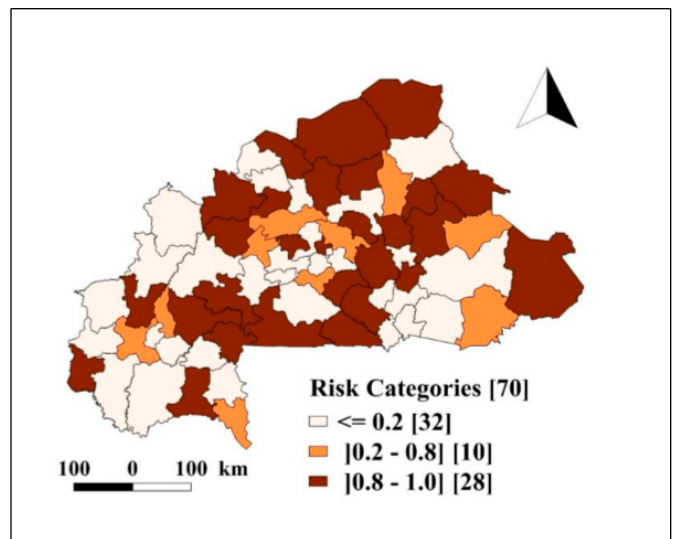
Figure 3. Burkina Faso health districts severe malaria deaths among children under five: exceedance probability ( ˆ P r ( e u i + ζ i > 1.01/ y )) of posterior relative risk based on Richardson’s classification. The number in bracket indicates the number of health districts within each category.